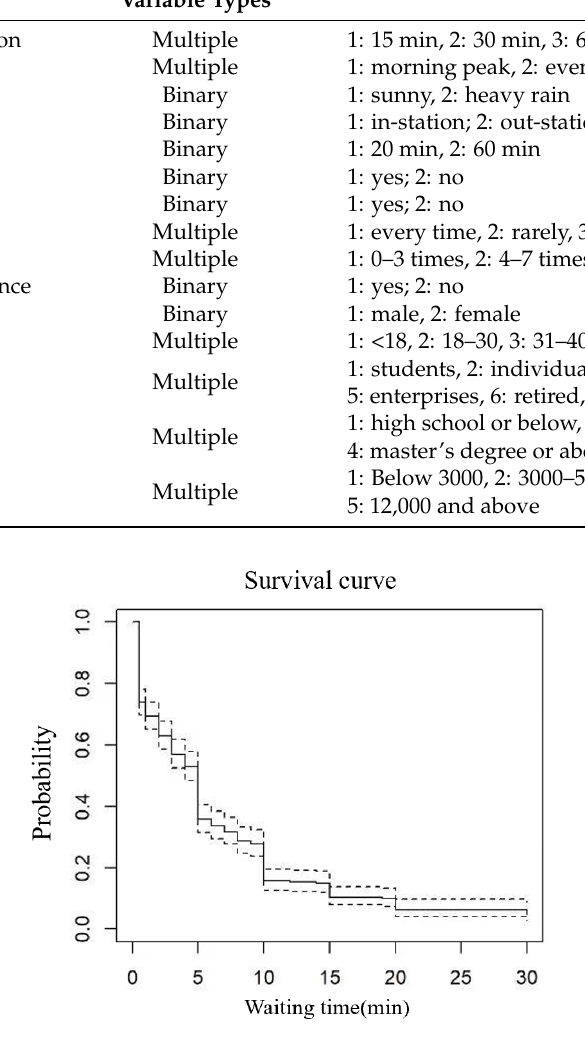
Figure 2. Survival curve of the passenger waiting tolerance during URT service interruptions. Table 10. AFT result of the passenger waiting tolerance during URT service interruptions.